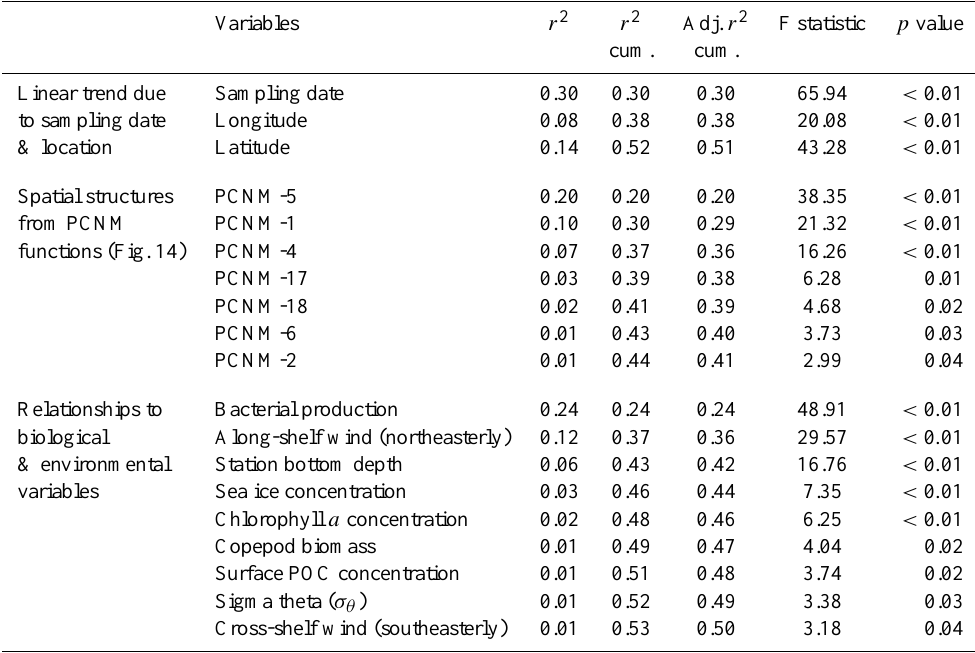
Table 3. Output from the forward selection of explanatory variables of vertical POC fluxes (154 stations, 17 size classes each, all integrated over the top 200m of the water column) based on the double criterion procedure as described in Borcard et al. (2011). For parsimony purpose, only the resulting reduced models of significant variables ( p ≤ 0 . 05) were used in the redundancy analyses (Fig. 14) and in the variation partitioning analysis of POC fluxes (Fig. 16). The list of all biophysical variables available for the present study is presented in Table 4. PCNM: principal coordinates of neighbor matrices (Borcard et al.,